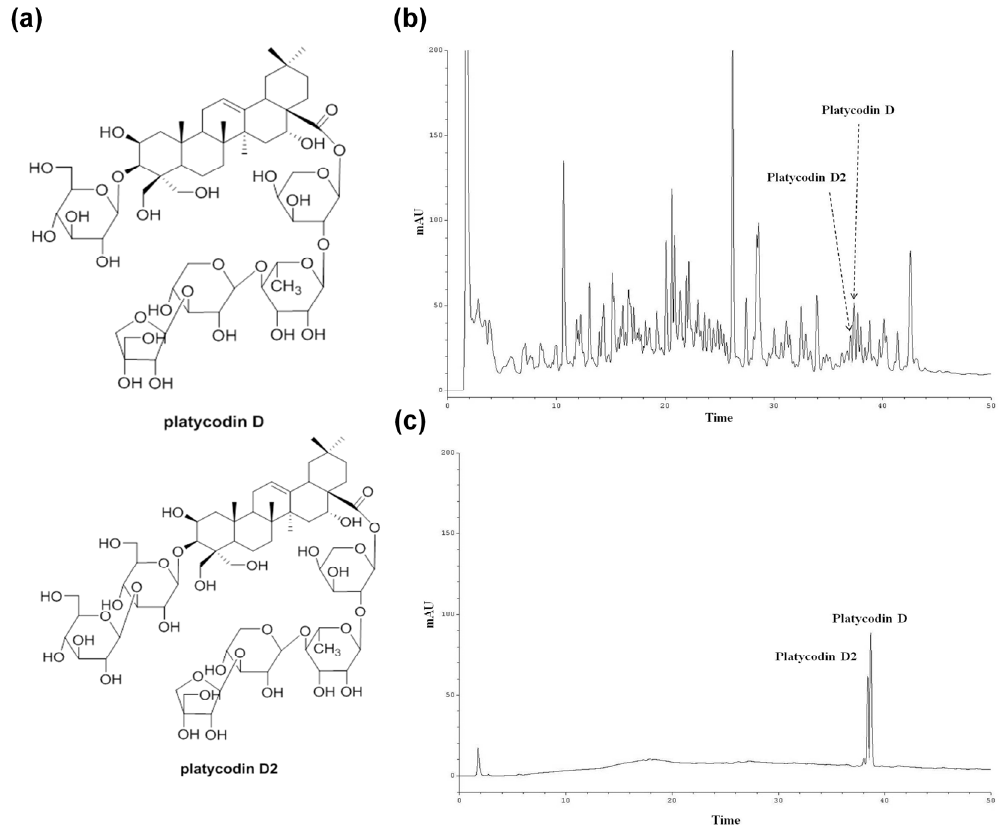
Figure 3. HPLC chromatograms of the EtOH extract of PG. ( a ) Structures of platycodin D and platycodin D2, ( b ) HPLC chromatograms of the root extract, and ( c ) HPLC chromatograms of standard compounds, platycodin D, and platycodin D2. HPLC analysis was carried out using a gradient elution on a phenomenex Kinetex RP-C18 column (5 µ, 100 A, 150 × 4.6 mm) at a flow rate of 1.0 mL/min, and with UV 210 nm detection.